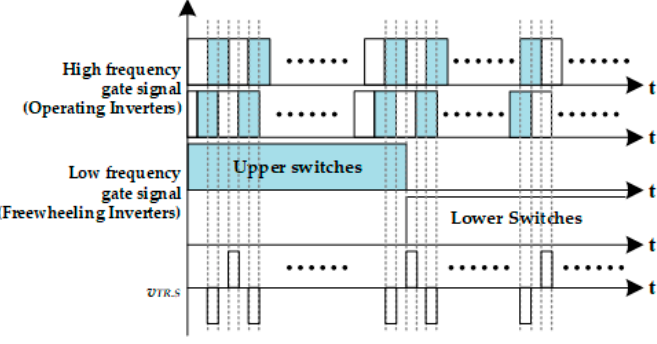
Figure 6. Gate signals of an operating inverter and a freewheeling inverter.